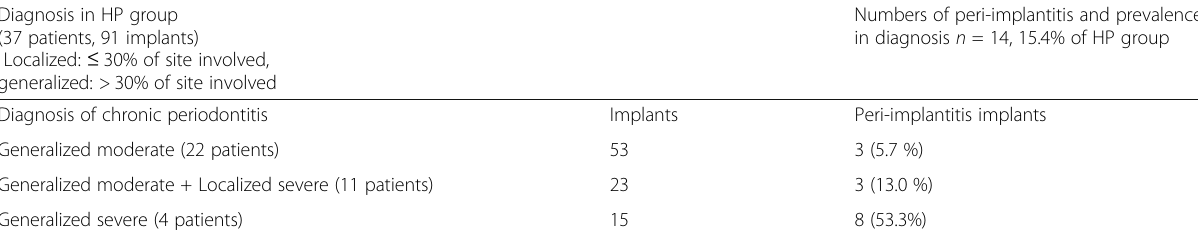
Table 3 Prevalence of peri-implantitis and periodontitis diagnosis in the HP group Diagnosis in HP group (37 patients, 91 implants) Localized: ≤ 30% of site involved, generalized: > 30% of site involved